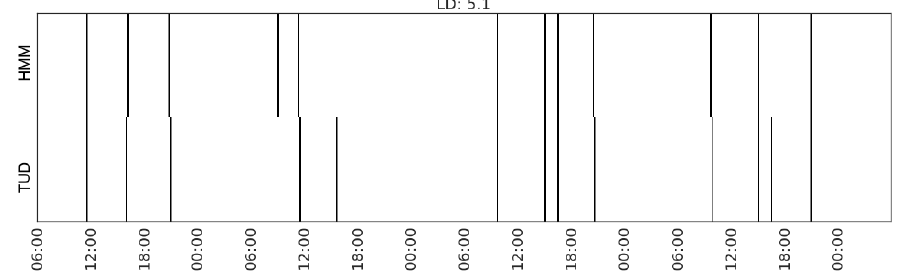
Figure 13. Recognising the activity of making hot drink in Household 1 with feature set (MS_watts_kitchen-appliances).